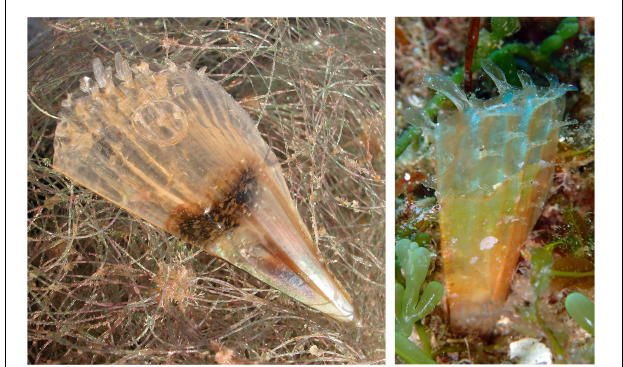
FIGURE 3 | Pinna nobilis (left) and P. rudis (right) juveniles at a size of 5–6 cm (antero-posterior length). Notice how the number of radiating ribs and the morphology of the scales clearly differs in both